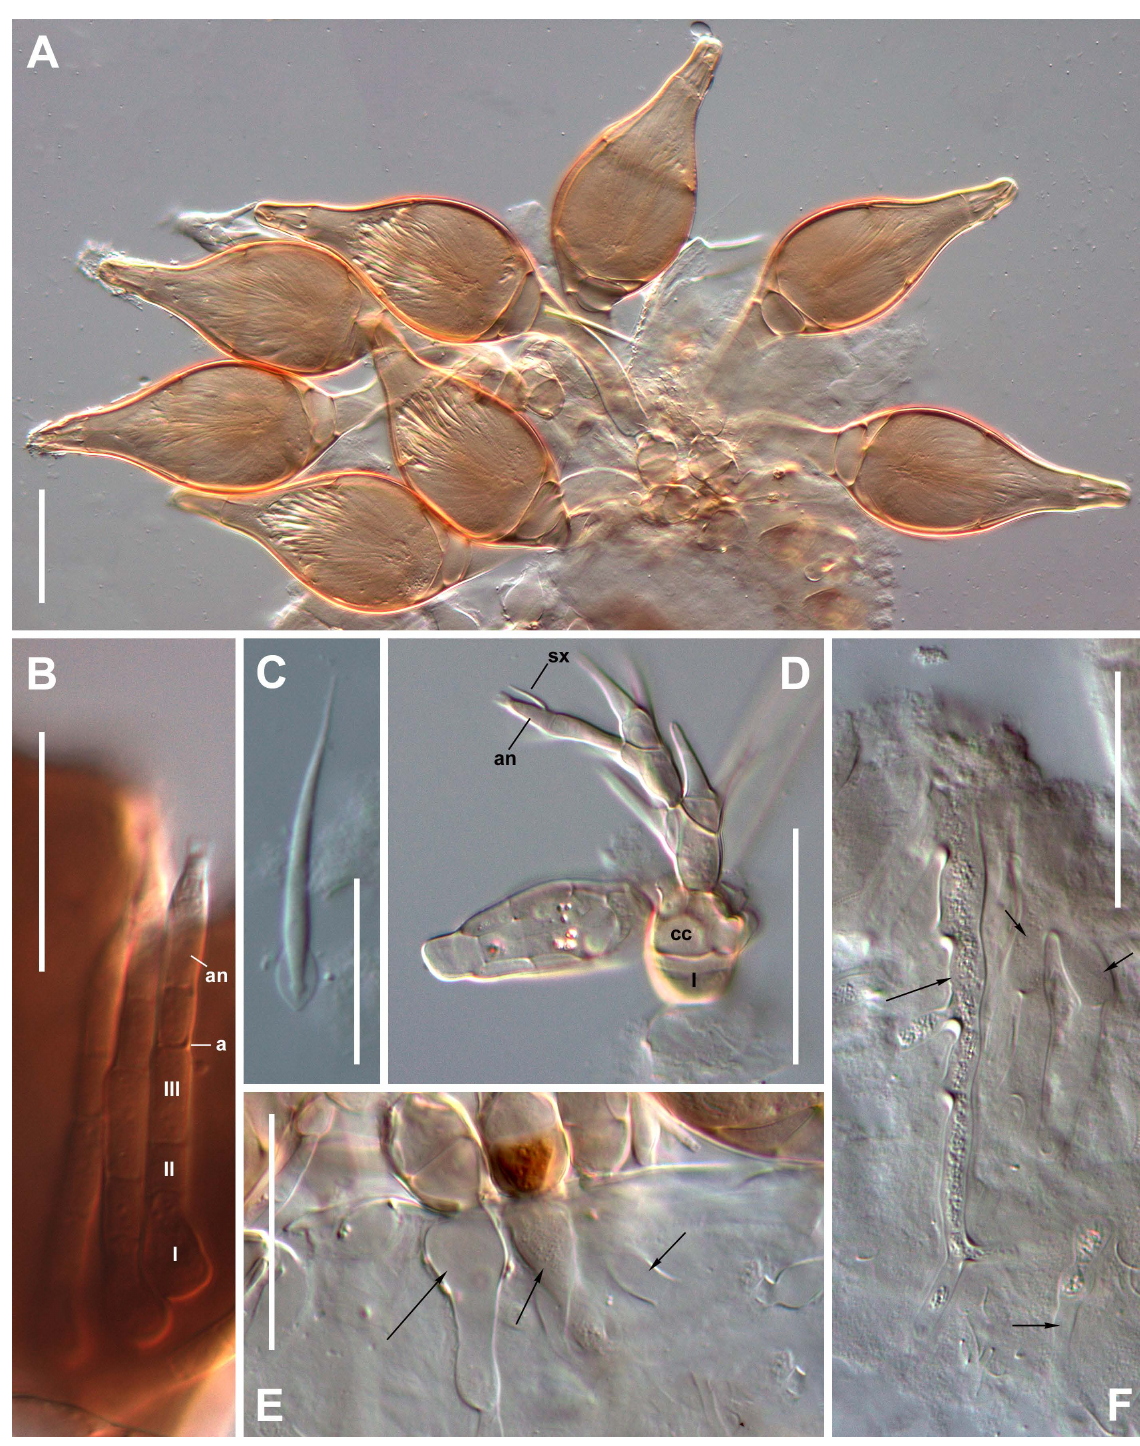
Fig. 16. Microsomyces psammoechi Thaxt. A . General habitus with several thalli corticating on host integument. B . Three sporelings with labelled receptacle cells (I, II, and III), the primary septum (a), and a primary antheridium (an). C . Ascospore. D . Young thallus showing cell I, one corticated cell (cc), and the primary antheridium (an) with spinose remaining of ascospore apex (sx). E – F . Haustoria penetrating the host body (arrows). Scale bars: A, D–F = 50 µm; B = 20 µm; C = 25 µm. Photographs from slides ZMUC C-F-124046 (A, C–F), ZMUC C-F-123679